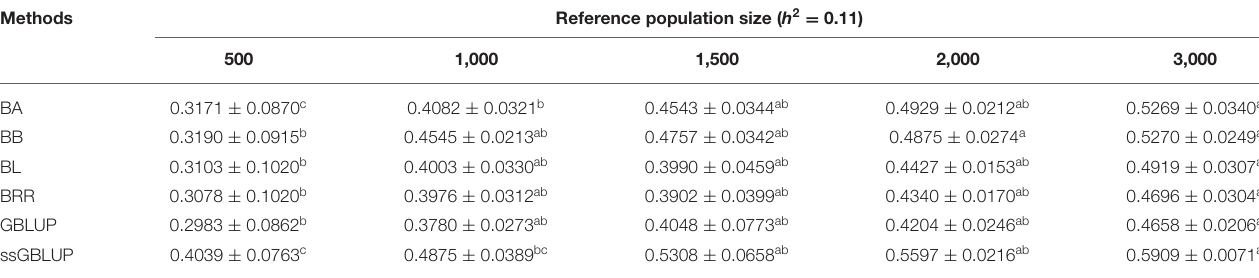
TABLE 5 | Accuracy of GEBV in five reference population sizes with heritability of live body weight under different models.